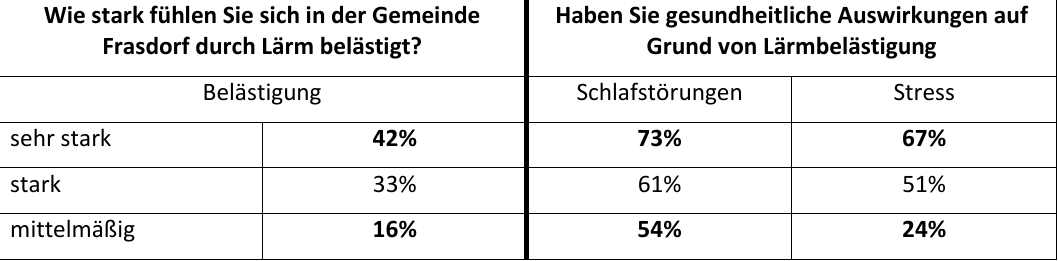
Auswirkungen Table 2: Significant correlation between degree of noise pollution and psychological health effects Wie stark fühlen Sie sich in der Gemeinde Frasdorf durch Lärm belästigt? Belästigung Schlafstörungen Stress 42% 73% 67% stark 33%